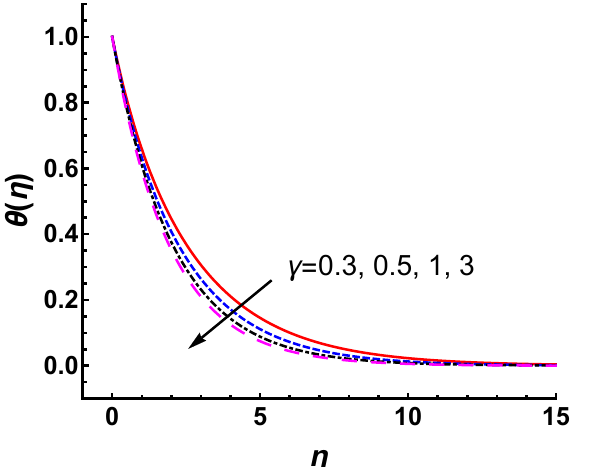
Figure 6. Temperature profile for different values of γ with Pr = 0.2, M = 2 and s =